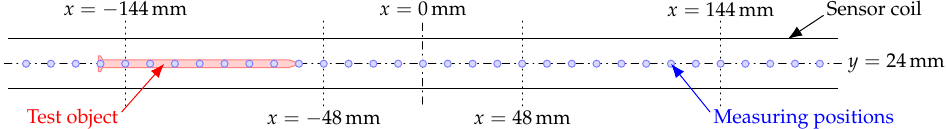
Figure 10. Schematic of the measurement positions (middle of the nail) and the relative size of the sensor coil and test object 8 on a section of the sensor coil 2.